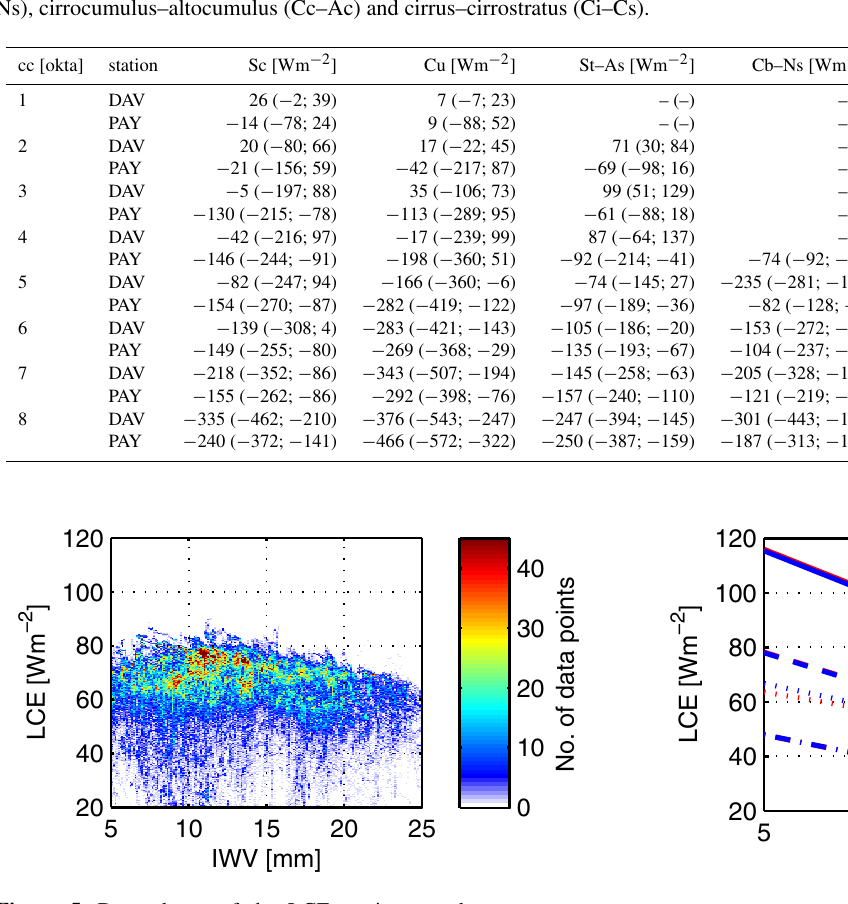
Table 3. The median and interquartile range of the total cloud radiative effect [Wm − 2 ] per okta for the two stations Davos (DAV) and Payerne (PAY) and the six cloud classes stratocumulus (Sc), cumulus (Cu), stratus–altostratus (St–As), cumulonimbus–nimbostratus (Cb–